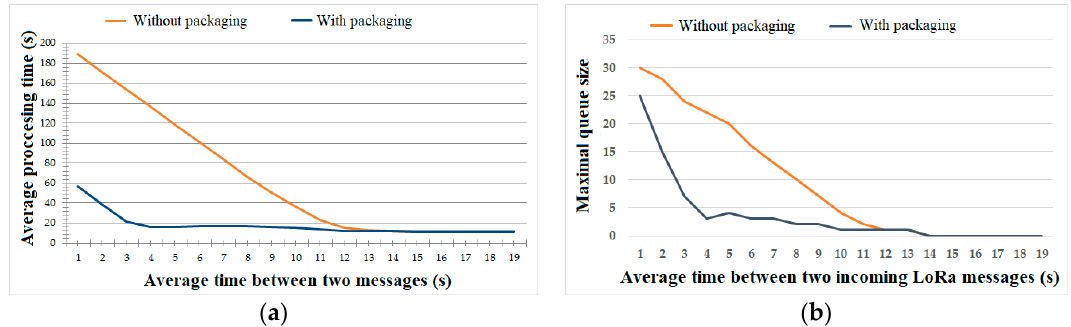
Figure 6. Distribution of delivery time through for the frequency of 1 message per second.